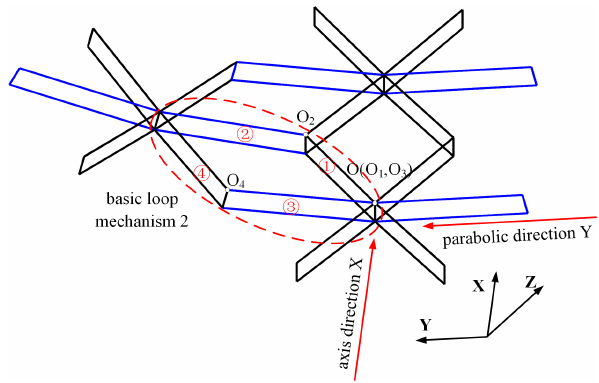
Figure 10. Basic loop mechanism 2 formed by module connection.